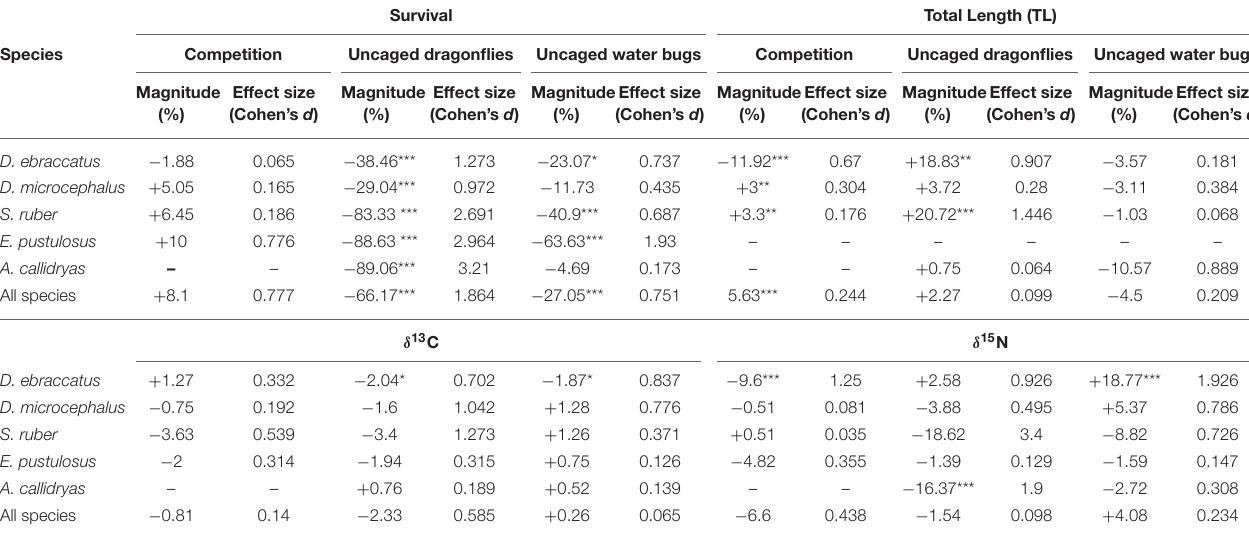
TABLE 2 | Magnitude and effect size of competition and predation on survival, size, and stable isotopic values of the amphibian community.